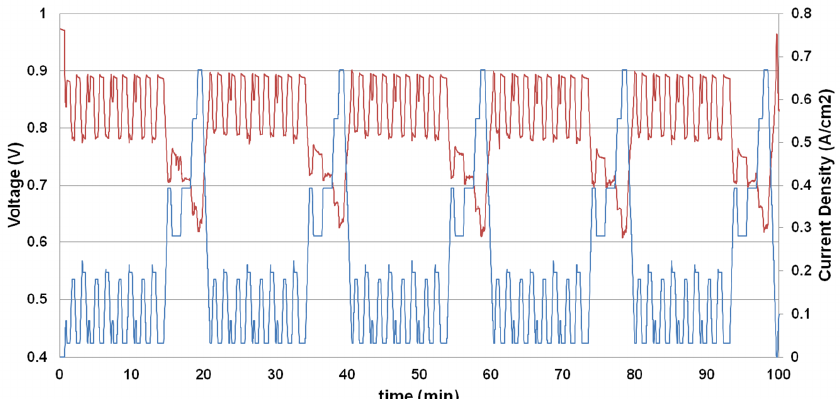
Figure 7. Evolution of cell voltage (in blue) during the load cycle test. Current density profile defined according to Appendix B is shown in red.